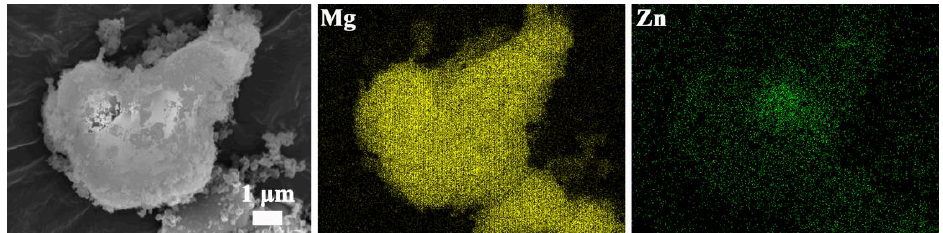
Figure 10. The element mapping images of MgH 2 -5 wt% ZnO composite after re-hydrogenation.